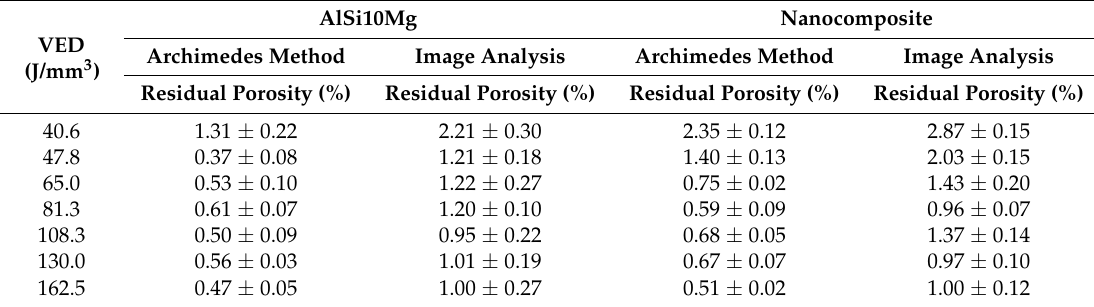
Table 2. Values of residual porosity with their standard deviation obtained by Archimedes method and by image analysis on AlSi10Mg and nanocomposite